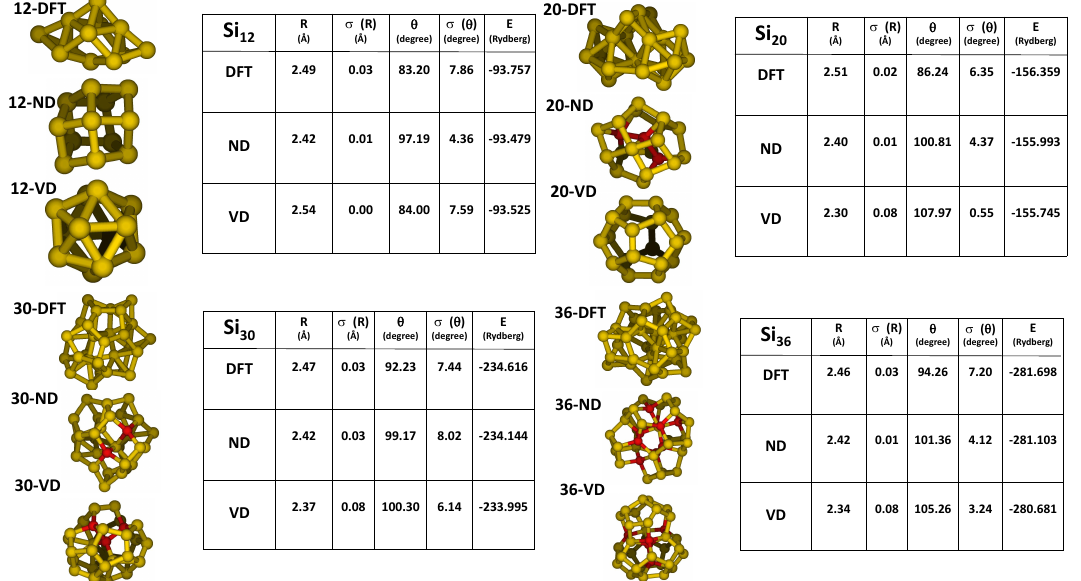
Figure 3. Structural and energetic results obtained by using different parametrizations of ReaxFF for Si clusters of size 12, 20, 30, and 36. The structural data R and θ are defined in Equations (2) and (3), respectively, while σ refers to their root-mean-square dispersion. DFT: density functional theory; ND: present optimization of ReaxFF; VD: parametrization for Si-based materials available in the literature